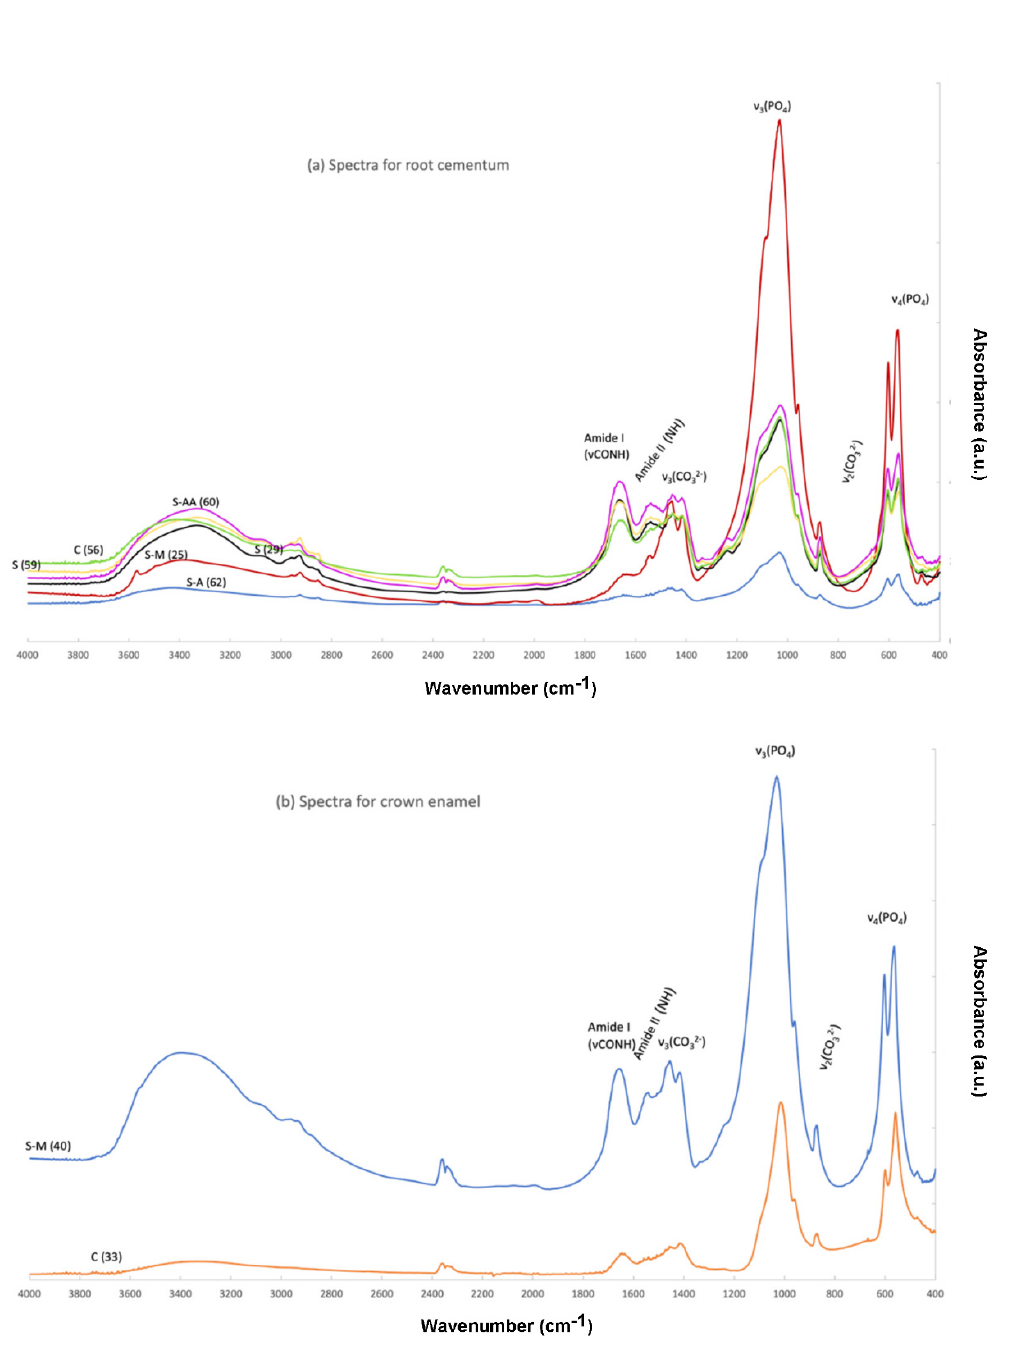
Figure 2. Fourier-transform infrared (FTIR) spectra of selected teeth samples (25- to 62-year-old patients): ( a ) spectra of root cementum samples; ( b ) spectra of crown enamel samples. The ranges cor- responded to the ν 2 (CO 32 − ) region (850–890 cm − 1 ), ν 3 (CO 32 − ) region (1350–1450 cm − 1 ), ν 3 (PO 43 − ) region (959–1230 cm − 1 ), ν 4 (PO 4 ) region (550–650 cm − 1 ) and the amide I region (1650–1780 cm − 1 ). The conditions of patients are indicated as follows: alcohol (A); smoker (S); treatment with psy- chotherapeutic drugs (M); anti-inflammatory drugs (AA); control (C). The age of each patient is shown in